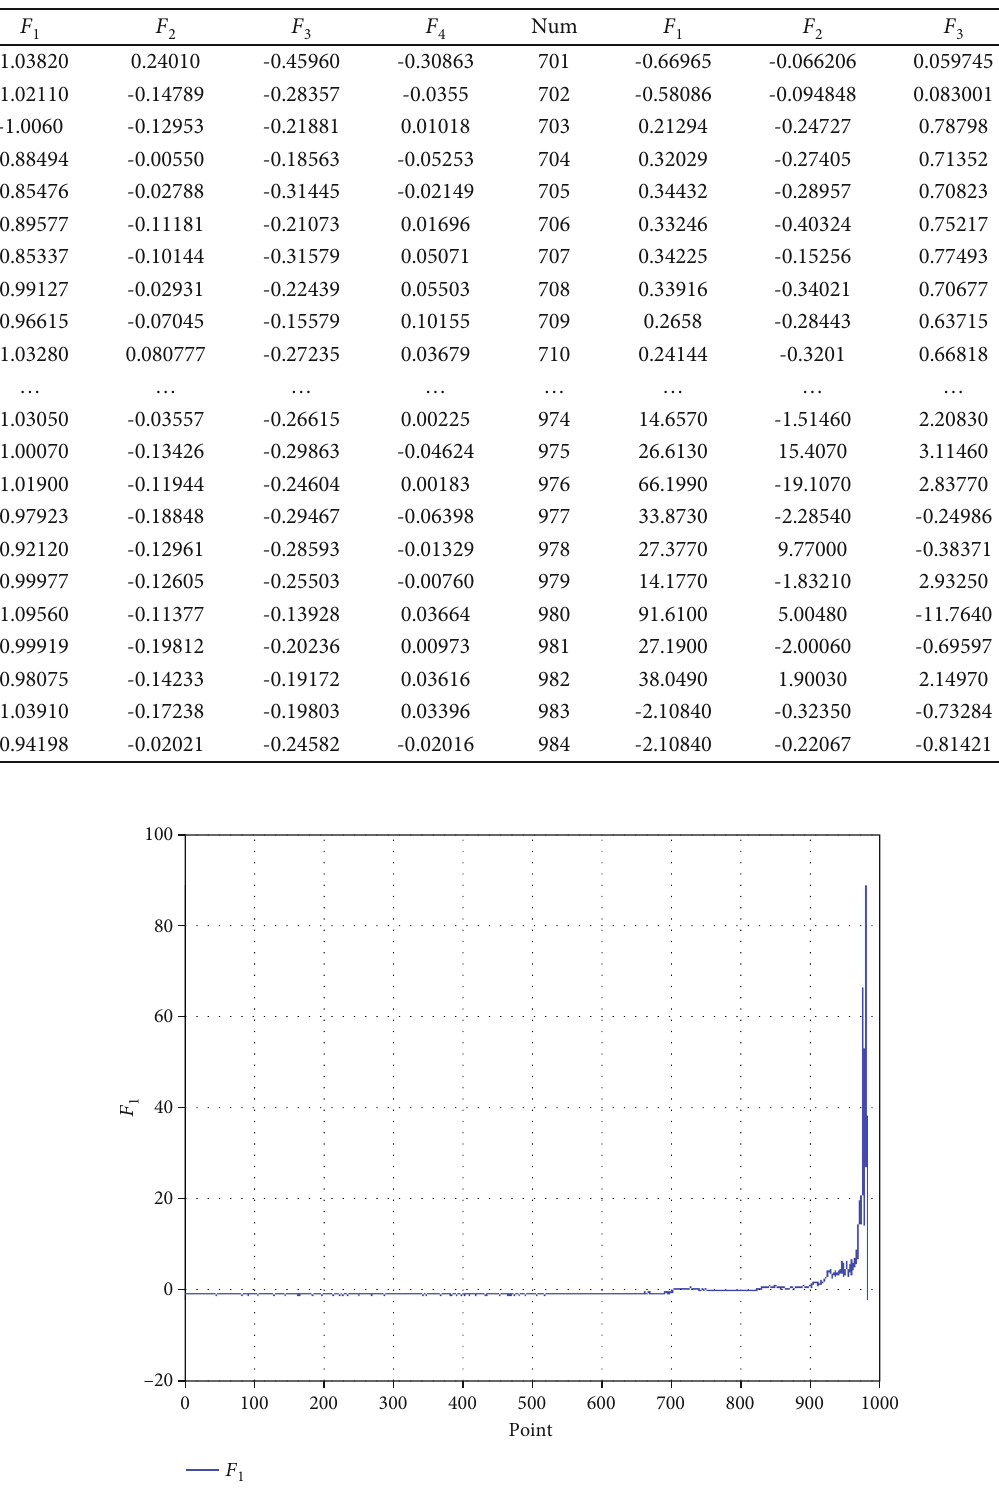
Figure 7: Performance declining curve of principal component F